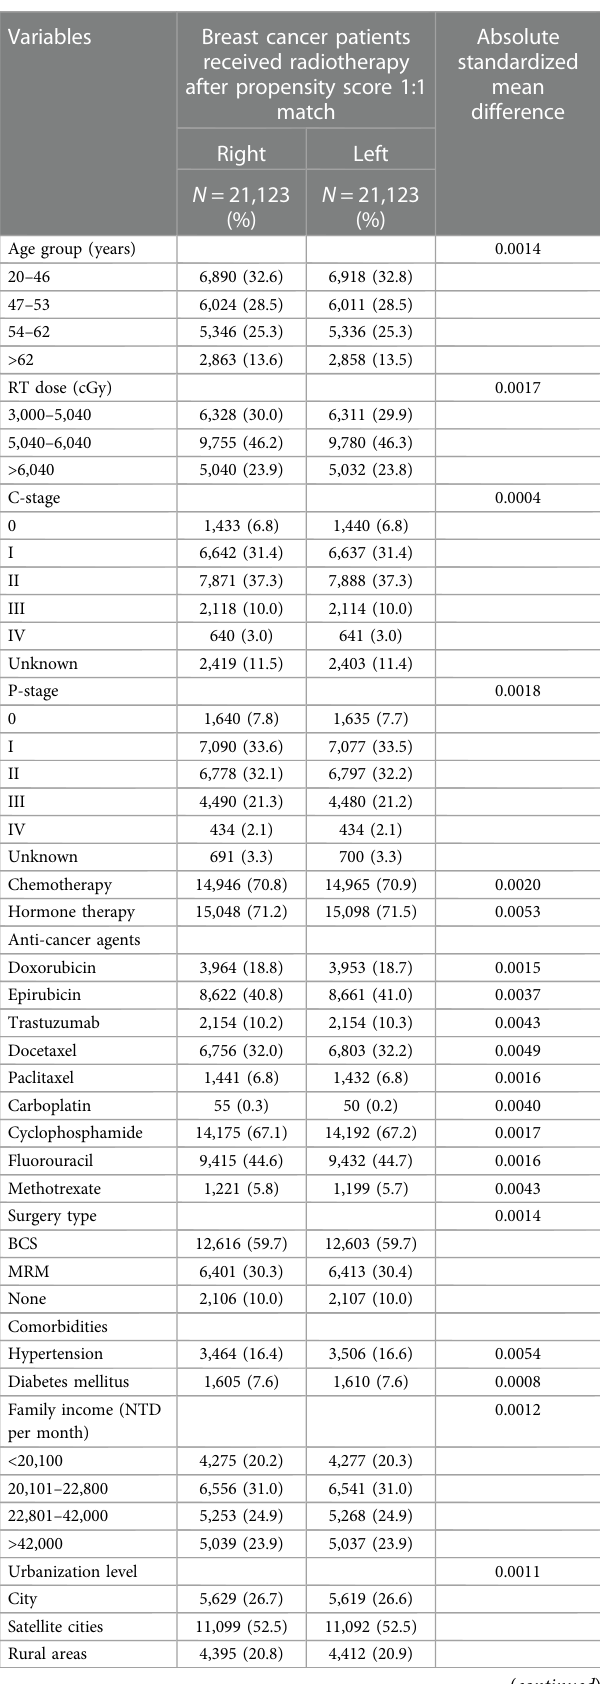
TABLE 1 Patient